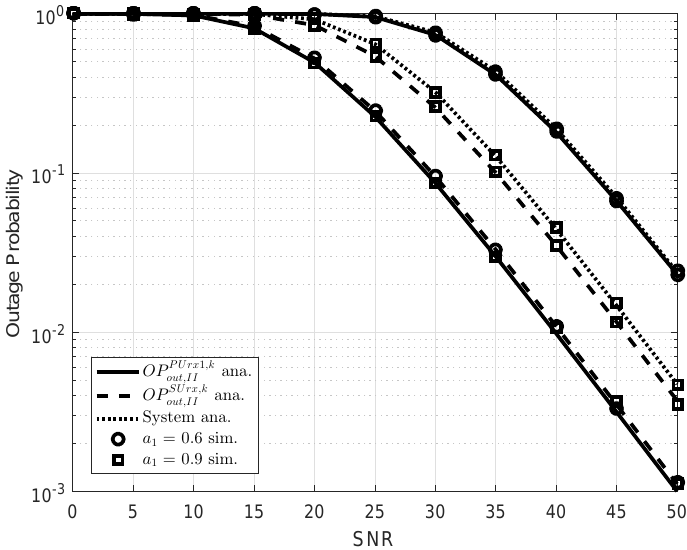
Figure 7. Scheme 2: Outage performance of PUrx 1 and SUrx versus SNR as varying a 1 . Figure 8 also indicates similar performance of Scheme 2 under varying power allocation factor a 1 .